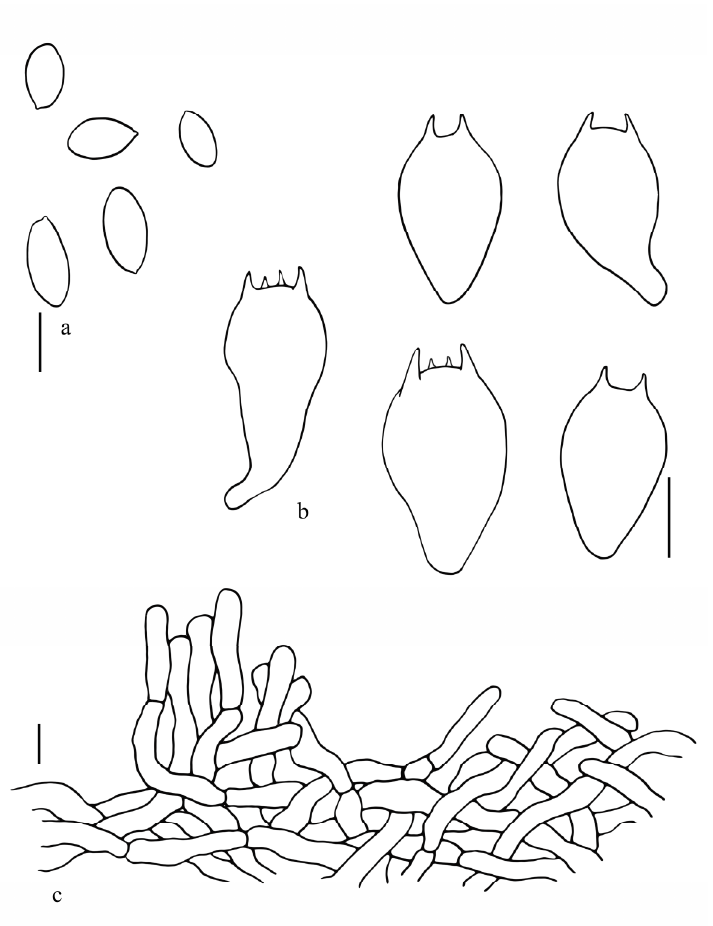
Figure 10. Suillellus lacrymibasidiatus . ( a ) Basidiospores; ( b ) Basidia; ( c ) Pileipellis. Scale bars: 10 μm.